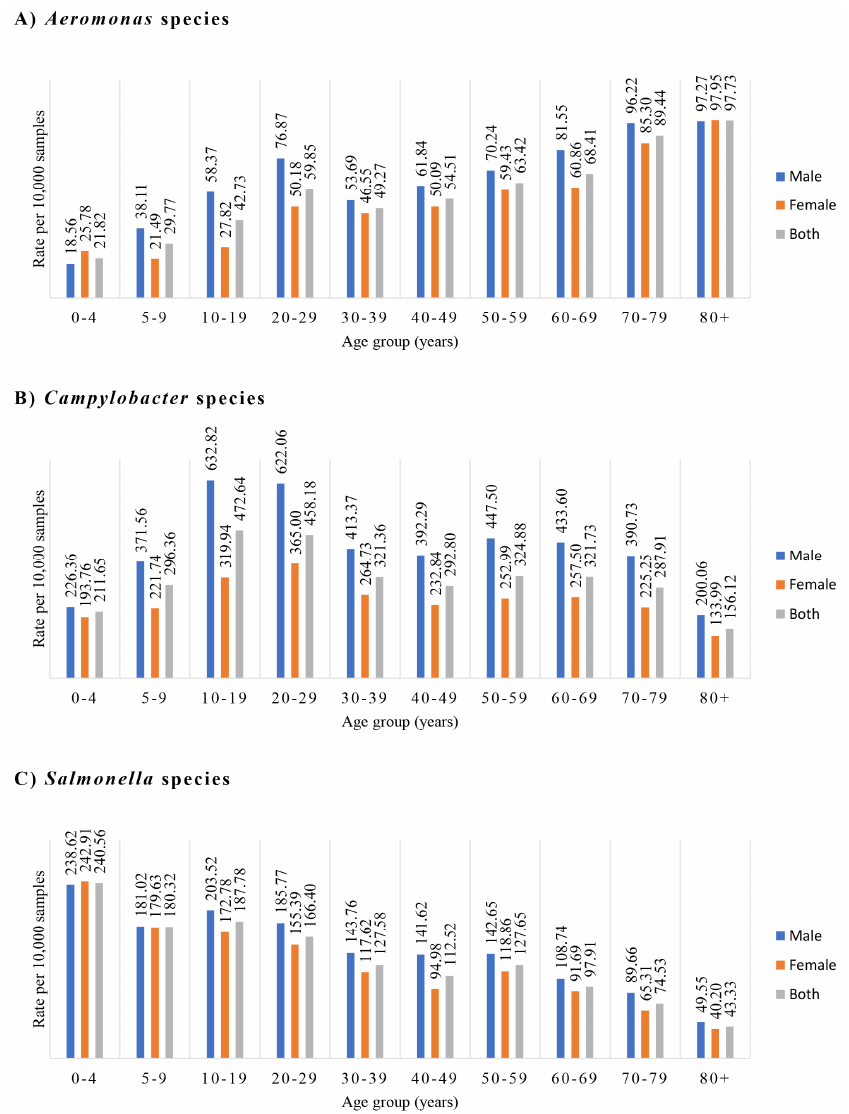
Figure 1. Isolation of Aeromonas species , Campylobacter species and Salmonella species during 2015–2019 from different age groups and gender. The bacterial pathogens were isolated from faecal samples of patients with gastroenteritis. The isolation rates were the positive isolations per 10,000 samples. ( A ) Aeromonas species, ( B ) Campylobacter species and ( C ) Salmonella species. Aeromonas species in human gastroenteritis showed a novel two peaks (20–29 age group and over 80 age group) infection pattern. The isolation of Aeromonas species was positively associated with age ( p < 0.001) and significantly higher in male patients than female patients ( p < 0.001). Campylobacter species was more isolated in the 10–29 age group; the isolation rate was negatively associated with patient age ( p < 0.001) and was significantly higher in male patients than female patients ( p < 0.001). Salmonella species was most often isolated in children of 0–4 age group; the isolation rate was negatively associated with patient age ( p < 0.001) and was significantly higher in male patients than female patients ( p < 0.001).